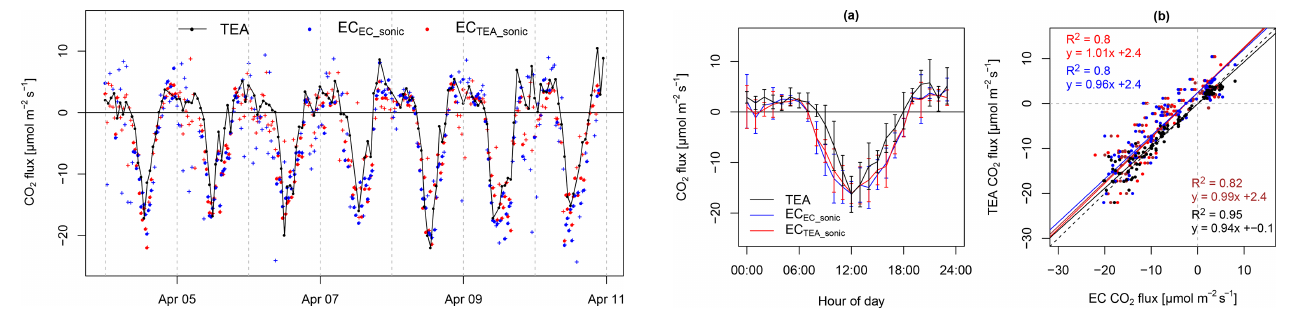
Figure 15. Mean diurnal cycle (a) and regression (b) of CO 2 fluxes measured by true eddy accumulation (TEA) and eddy covariance (EC) for the period 4–7 April 2015. Flux integration interval for both methods is 30min. TEA fluxes were obtained every 60min and EC fluxes every 30min. The two alternative EC flux calcula- tions shown, in blue and red, respectively, are from two separate Gill-R3 sonic anemometers using CO 2 density data from a single LI-7500 gas analyzer. The EC fluxes are quality-flag-filtered, ac- cepting flags ≤ 1 on a scale of 0, 1, and 2 (Foken et al., 2004) and filtered for consistency of EC fluxes from the two anemometers, ac- cepting EC fluxes with a maximum relative flux difference of 50%. Error bars indicate ± 1 standard deviation. (b) Scatterplot and lin- ear model fit for TEA fluxes versus EC fluxes. The three EC flux versions shown are fluxes from the TEA sonic (in red), from the EC sonic (in blue), and the mean of the fluxes from the TEA and the EC sonic (in brown). Also shown are EC fluxes from EC sonic versus EC fluxes from TEA sonic (in black). Regression statistics shown are the coefficient of determination, R 2 , and the linear model equation from a standard major axis regression (Legendre and Leg- endre, 1998; Sokal and Rohlf, 1995). The same color code (red, blue, brown, black) applies to all graphical elements, i.e., points, re- gression lines (solid lines), and regression coefficients. The dashed black line is the 1 : 1